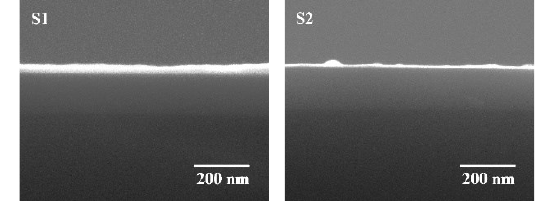
Fig. 1. SEM cross-sections of S1 and S2 films.